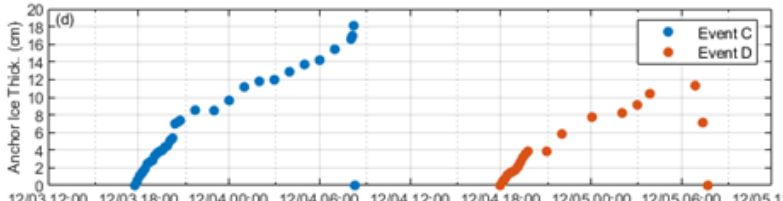
Figure 7. Time series of results of DEP-3 showing (a) air temperature and incoming solar radiation, (b) water depth at the WSC gauge #05DF001, (c) water temperature on the substrate, and (d) anchor ice thickness above the substrate for events C and